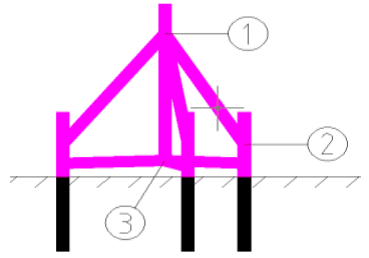
Figure 3. Selected typical tubular joints of the OWT tripod substructure.